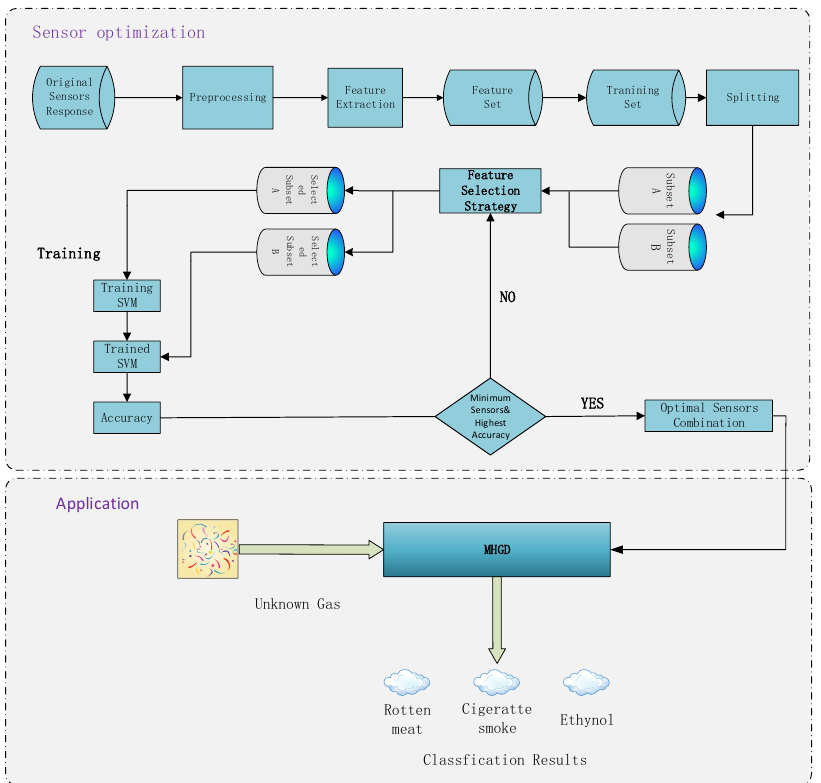
Figure 6. The data flow diagram of